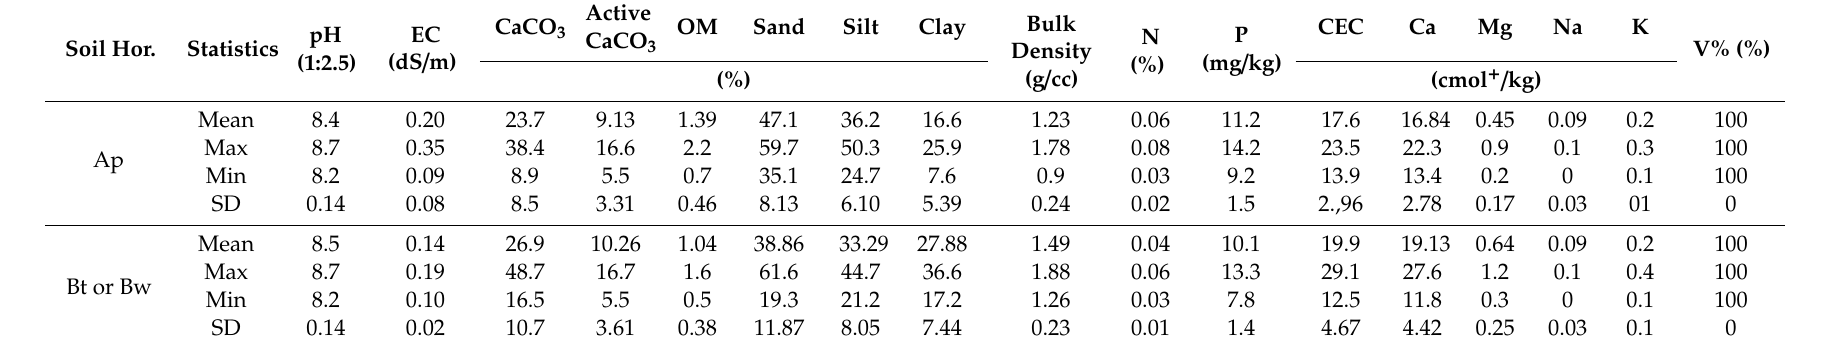
Table 2. Descriptive statistics of selected physico-chemical and chemical parameters of soil